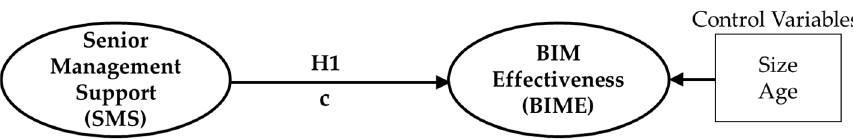
Figure 2. Direct effects model.